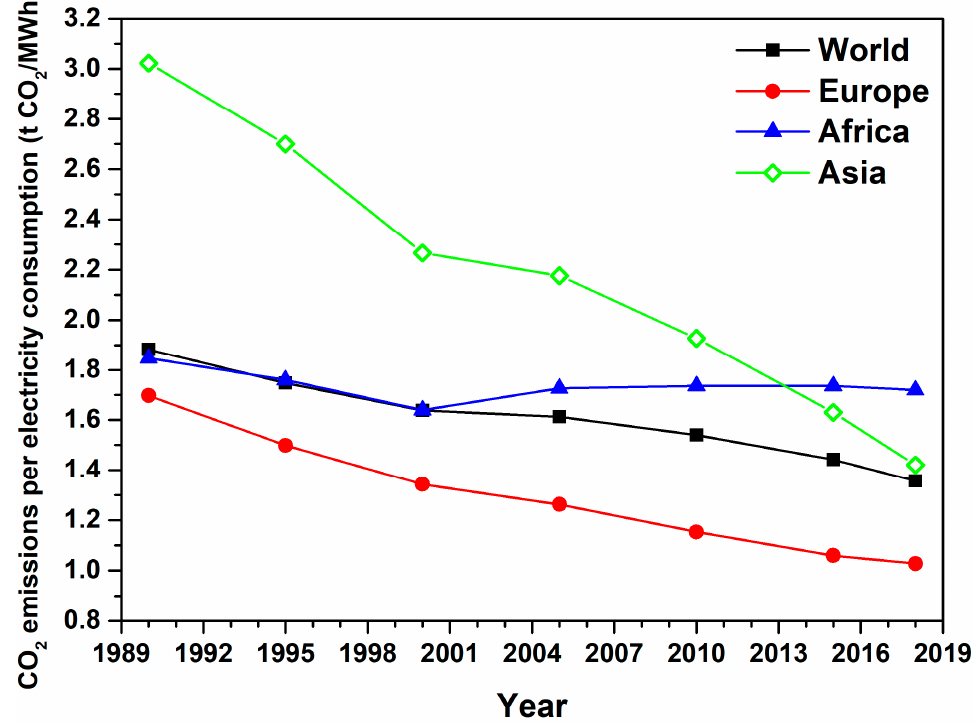
Figure 1. CO 2 emissions per electricity consumption in the world, Europe, Africa, and Asia [1]. Europe is the lowest producer of CO 2 , reaching a value about 1.0 tCO 2 /MWh in